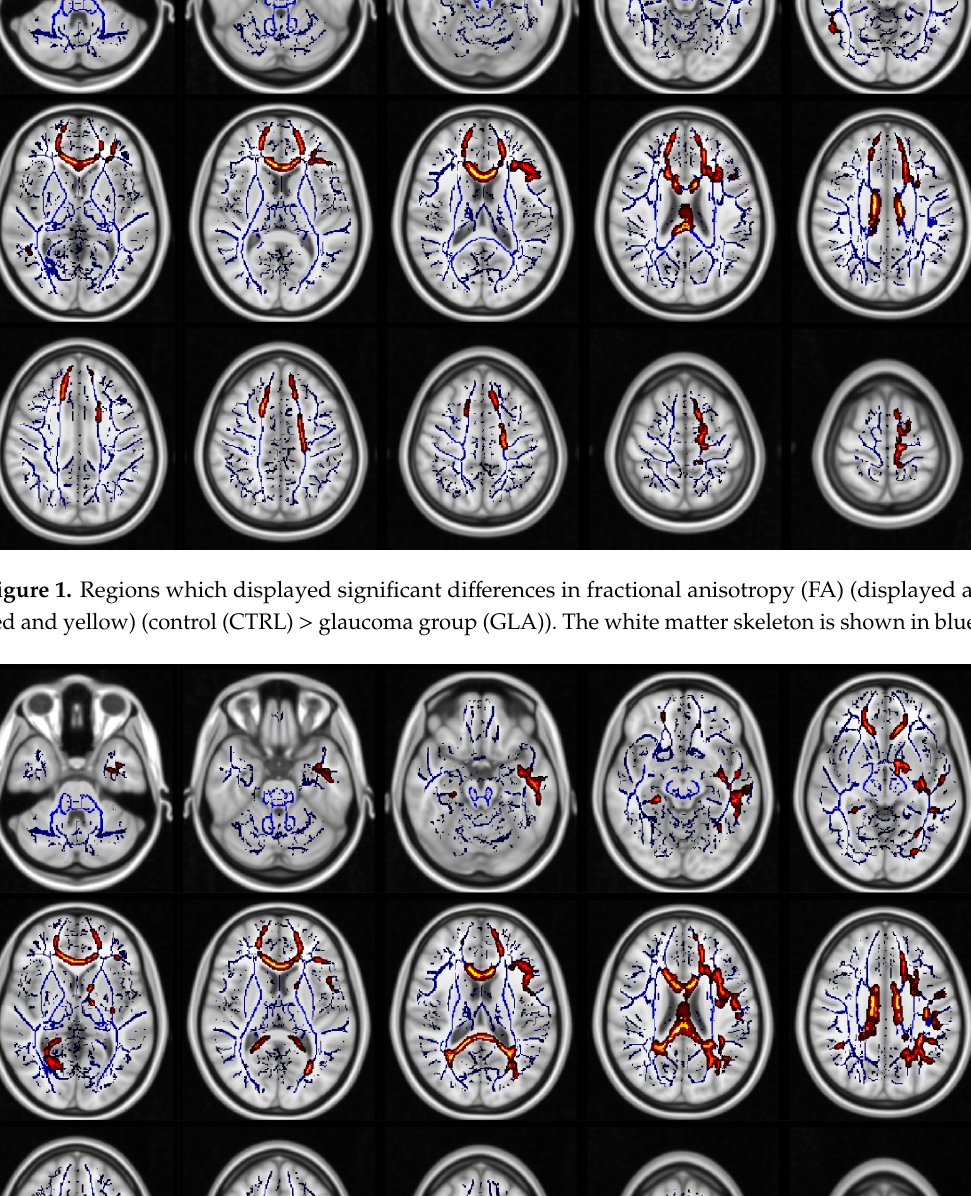
Figure 3. Regions which displayed significant differences in mean kurtosis (MK) (displayed as red and yellow) (CTRL) > glaucoma group (GLA)). The white matter skeleton is shown in blue.